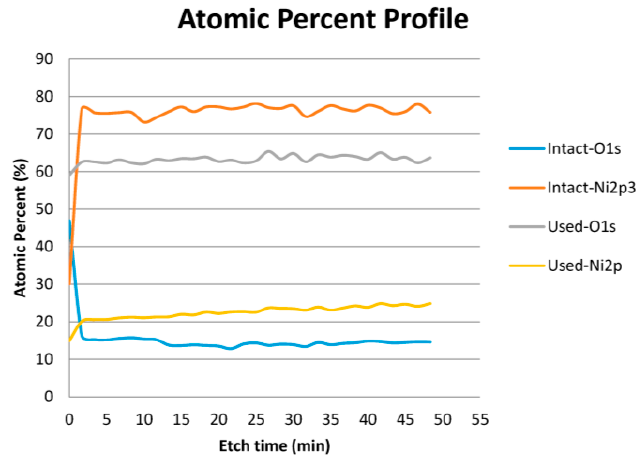
Figure 5. Atomic percentage profile of nickel and oxygen before and after the experiment.